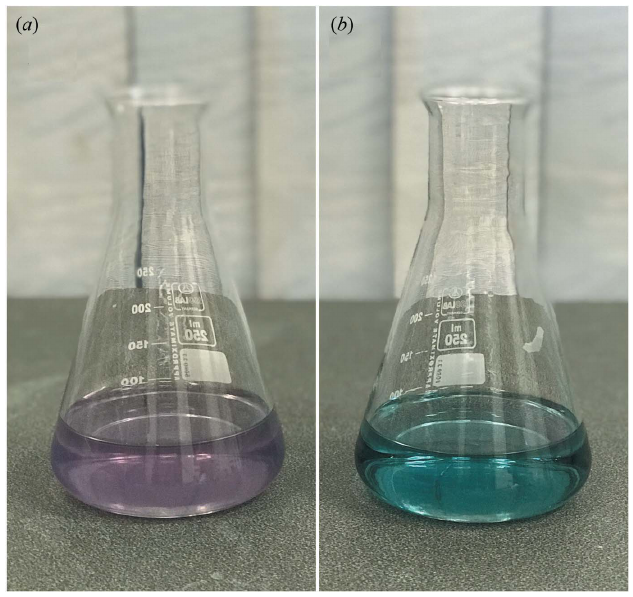
Figure 3 Complexometric titration of free Ca 2+ in the remineralization solution using 17% EDTA. Note that the colorless remineralization solution turned purple when Eriochrome Black T formed a complex with unbound Ca 2+ ( a ). However, when 200 m l of 17% EDTAwas added, unbound Ca 2+ formed a complex with EDTA instead and the solution hence immediately turned blue as indicated by Eriochrome Black T. The saturation point of dark blue color indicates the absence of free Ca 2+ available in the remineralization solution ( b